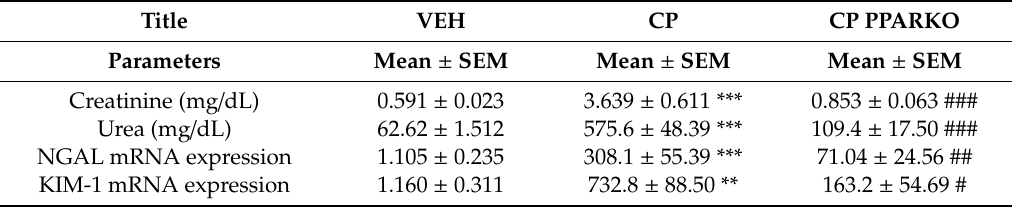
Table 1. E ff ects of peroxisome proliferator-activated receptor alpha (PPAR- α ) deletion on renal injury and